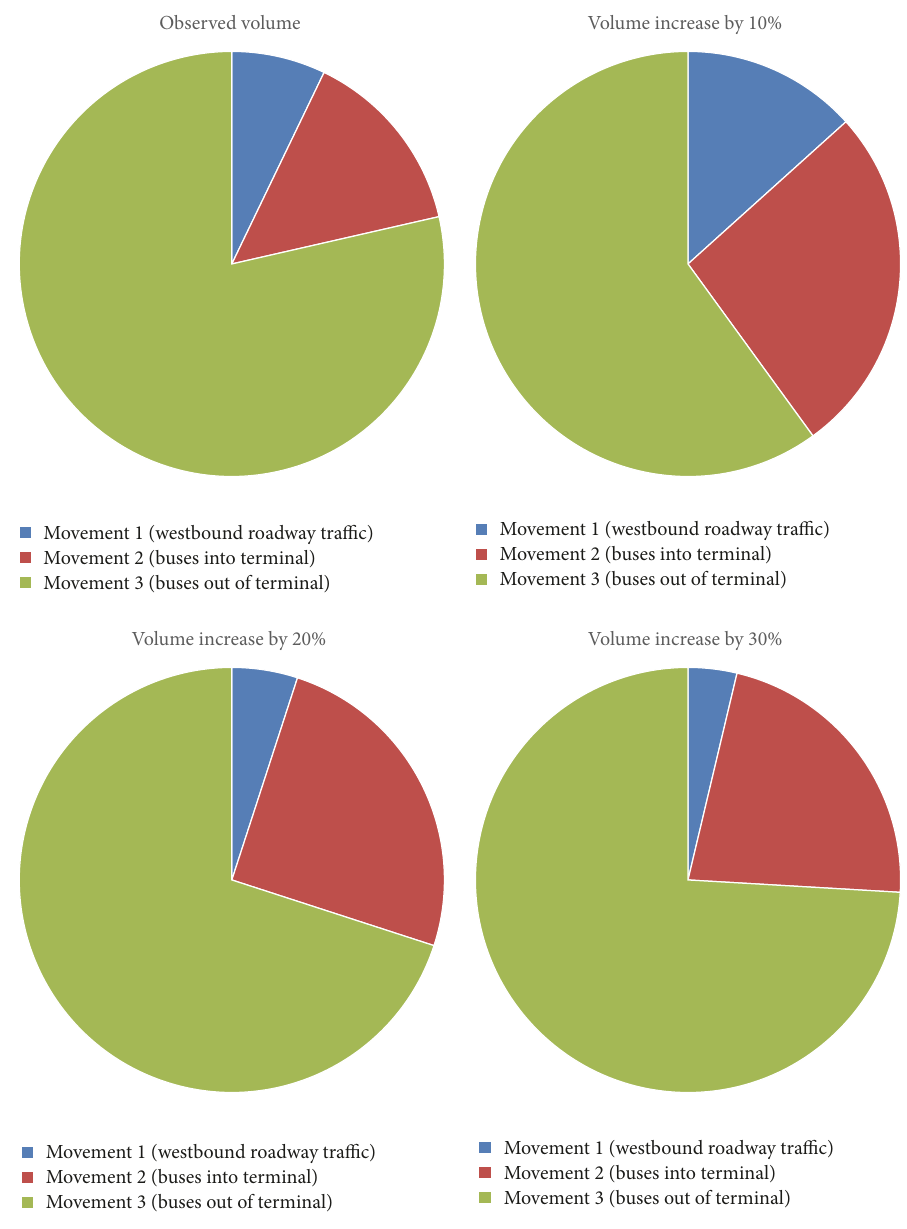
Figure 11: Sensitivity analysis of conflicts distribution (current